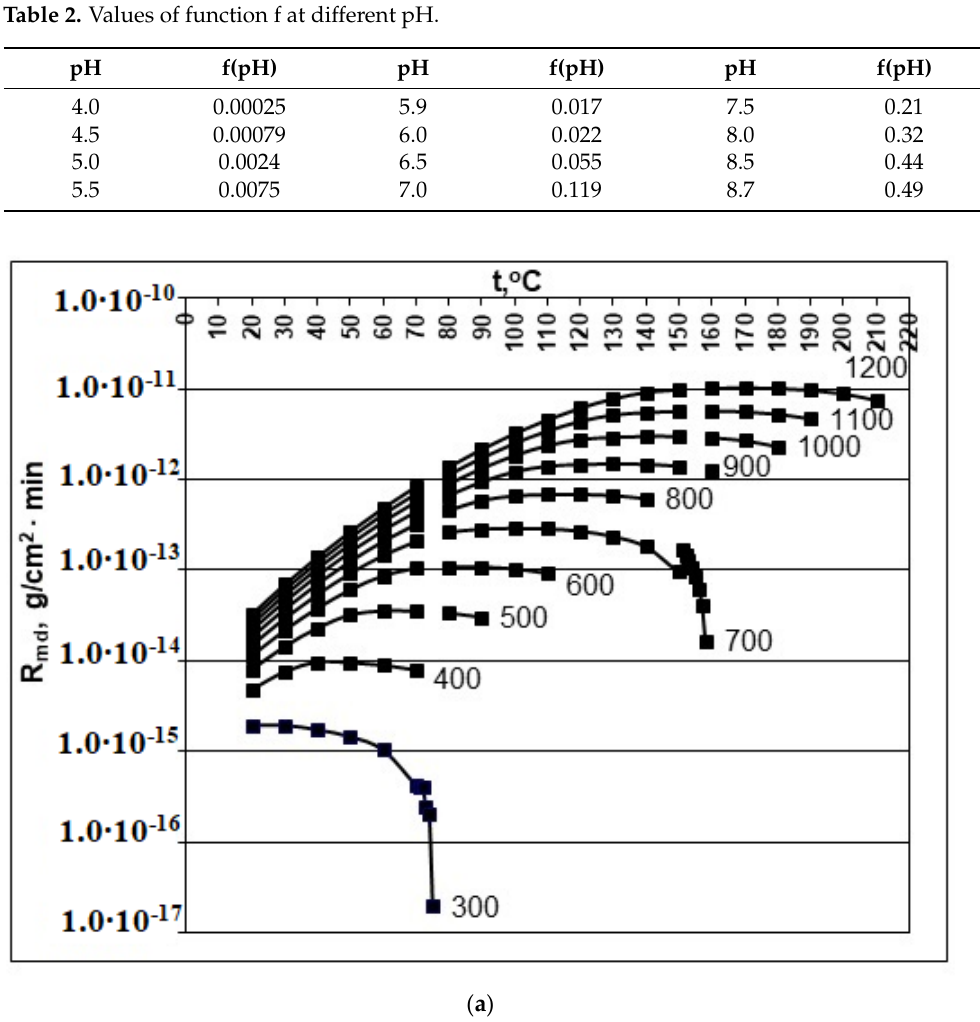
Table 2. Values of function f at different pH.